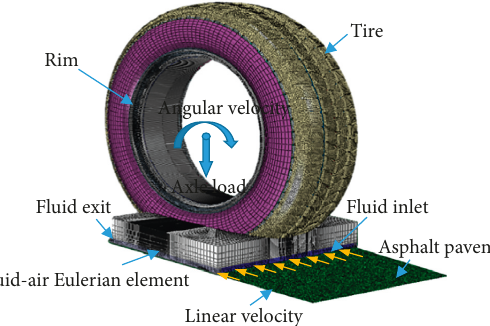
Figure 4: Components of the tire hydroplaning